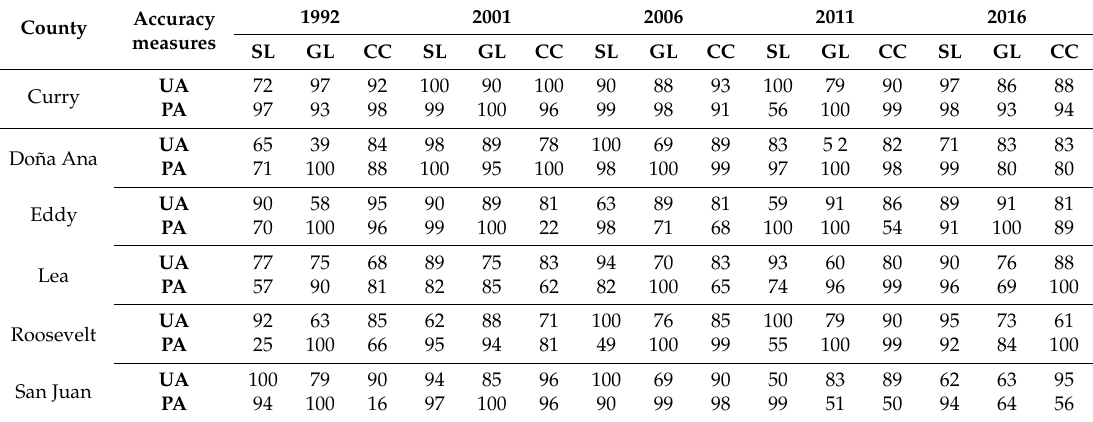
Table 5. User and producer accuracies (%) of the main land cover classes important for New Mexico’s Food Energy and Water systems (FEWS) over the study counties.